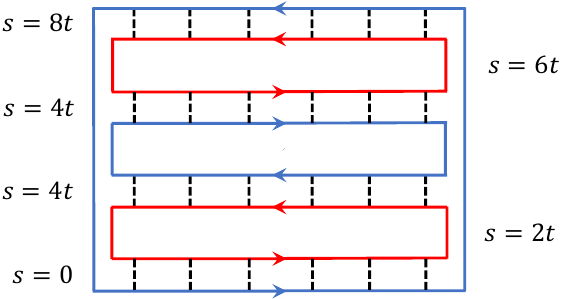
Figure 6 . The contour convention of n = 2 R(cid:19)enyi entropy. The blue (red) solid line represents the subsystem a = 1 ( a = 2). The arrows indicate the direction of the time parametrization. The black dashed lines indicate the interaction between two